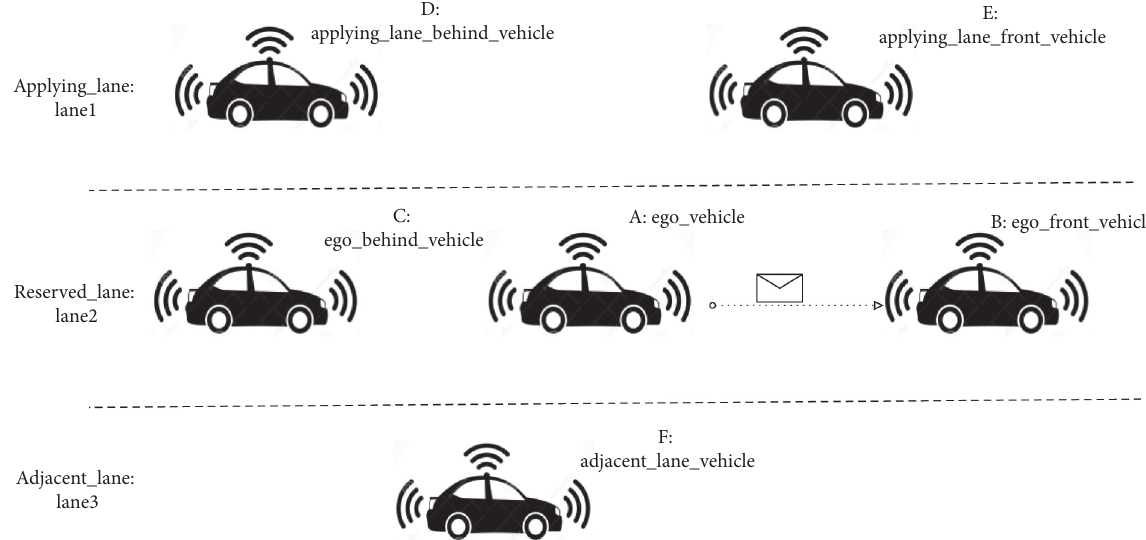
Figure 9: View of the ego-vehicle